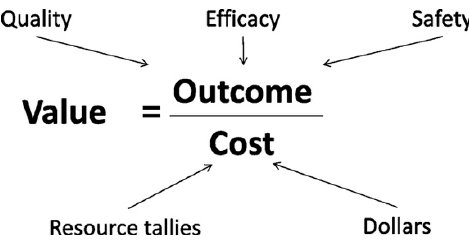
Figure 2. The neonatal value equation. Reproduced with permission from Pediatrics Vol. 137, Issue 3, e20150312. Copyright © 2016 by the American Academy of Pediatrics (AAP).